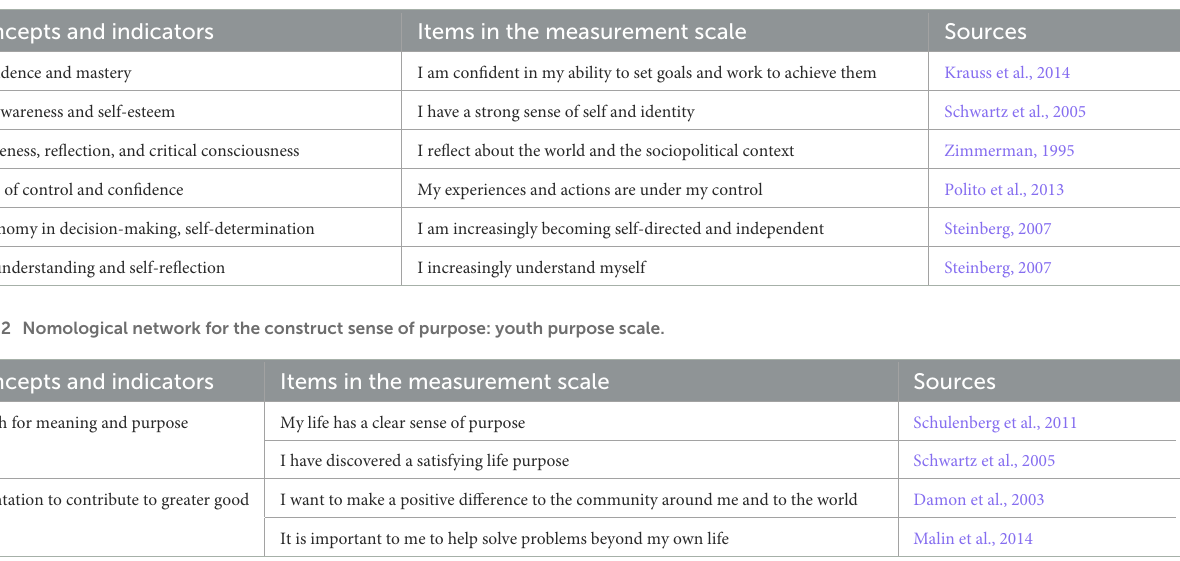
TABLE 1 Nomological network for the construct personal agency: agency in the transition to adulthood scale.